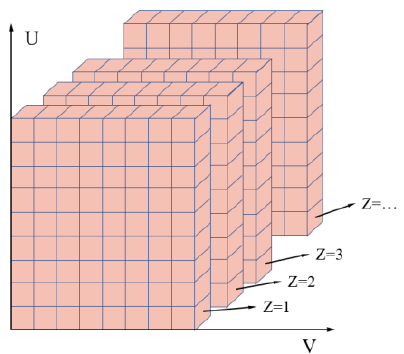
Figure 4. Structured 3D model to express tooth surface errors.